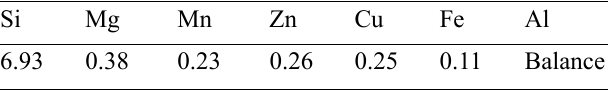
Table 1. Chemical composition (wt %) of A356 Alloy.